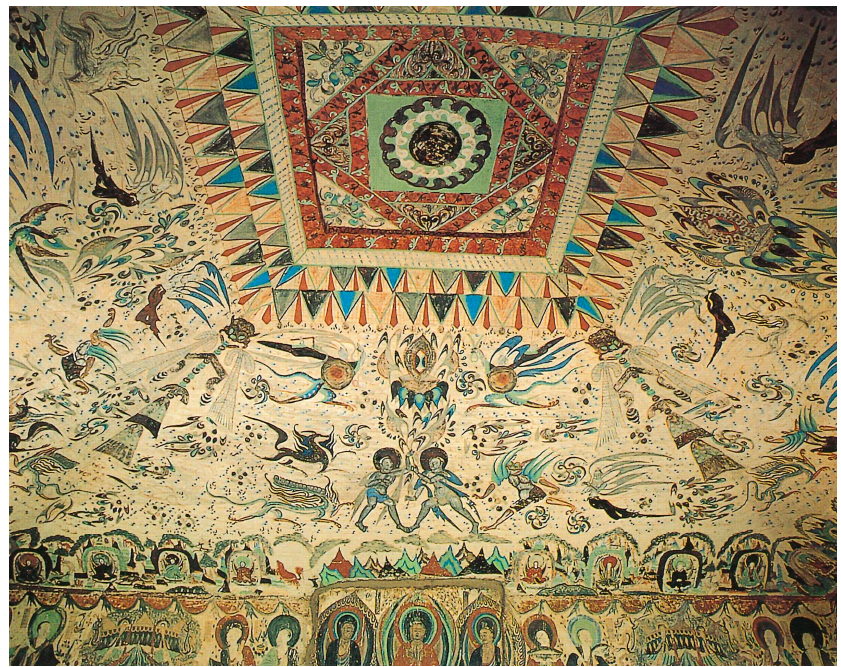
Figure 20. Fuxi and Nüwa, east slope of Mogao cave 285, Western Wei dynasty (535–56). ( Dunhuang Mogao Shiku 2011, pl. 143). ©Wenwu Press. This figure published with permission of Wenwu Press and cannot be used or copied without their